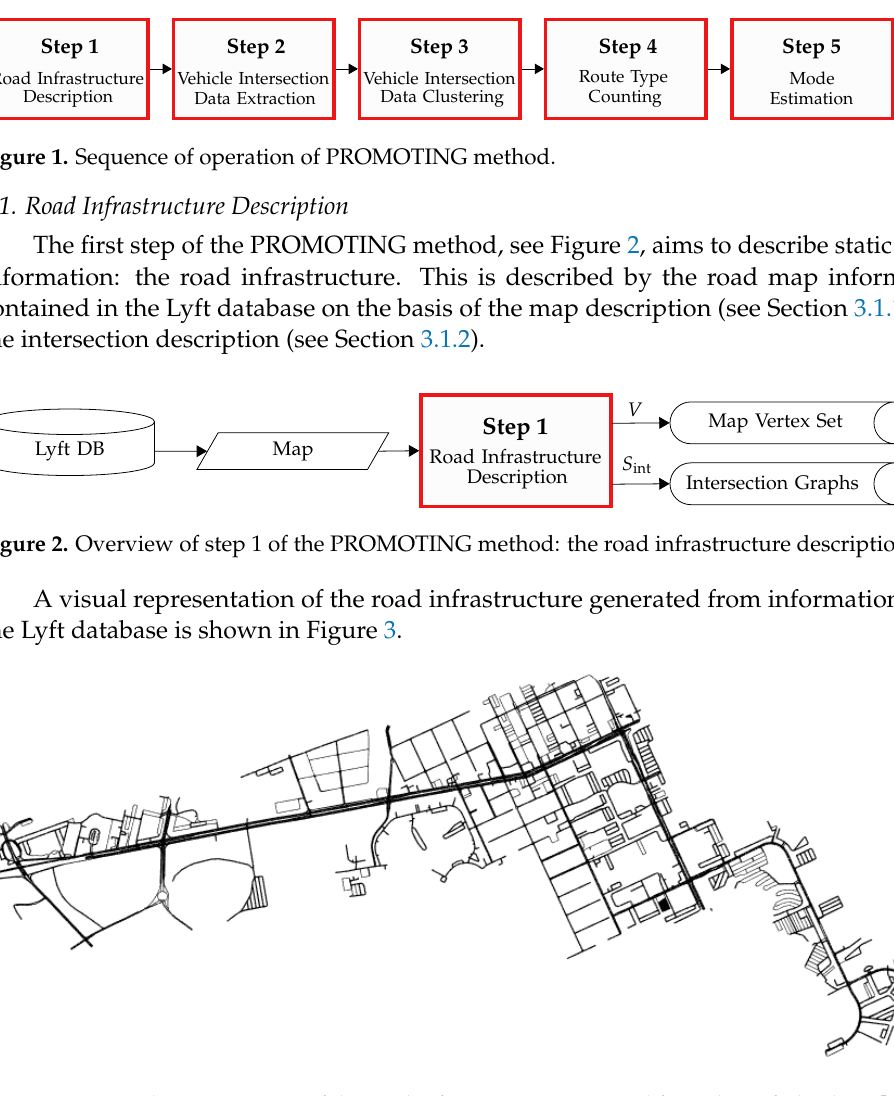
Figure 3. Shown is a visual representation of the road infrastructure generated from the Lyft database [25].